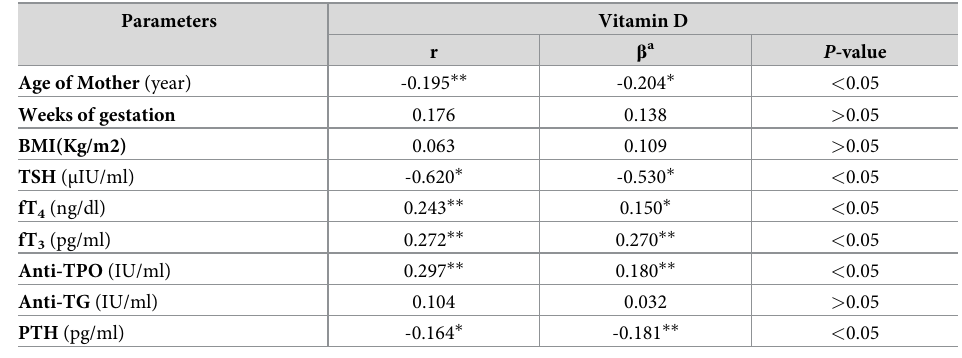
r: Pearson correlation, β a : Beta coefficient * Correlation is significant at the 0.05 level